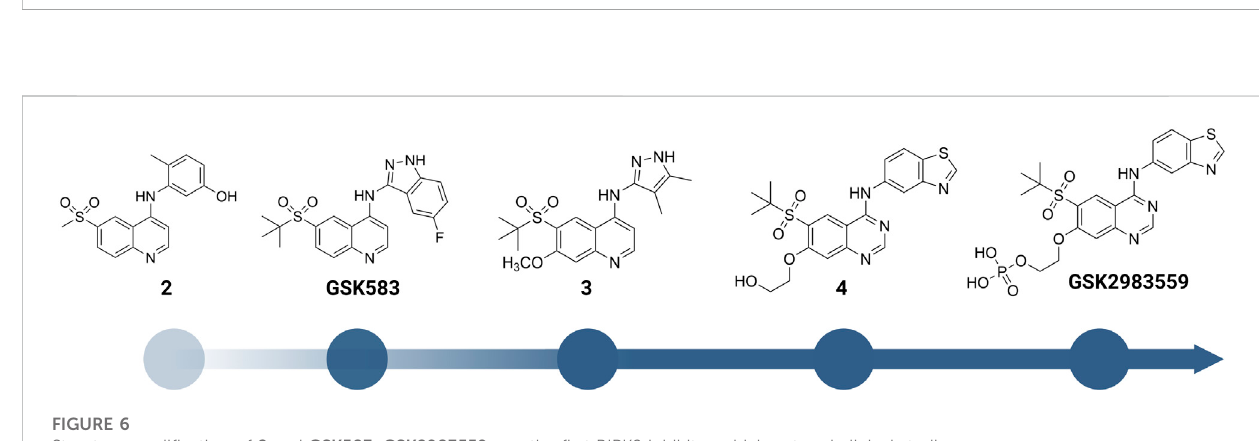
Structure modi fi cation of 2 and GSK583 . GSK2983559 was the fi rst RIPK2 inhibitor which entered clinical